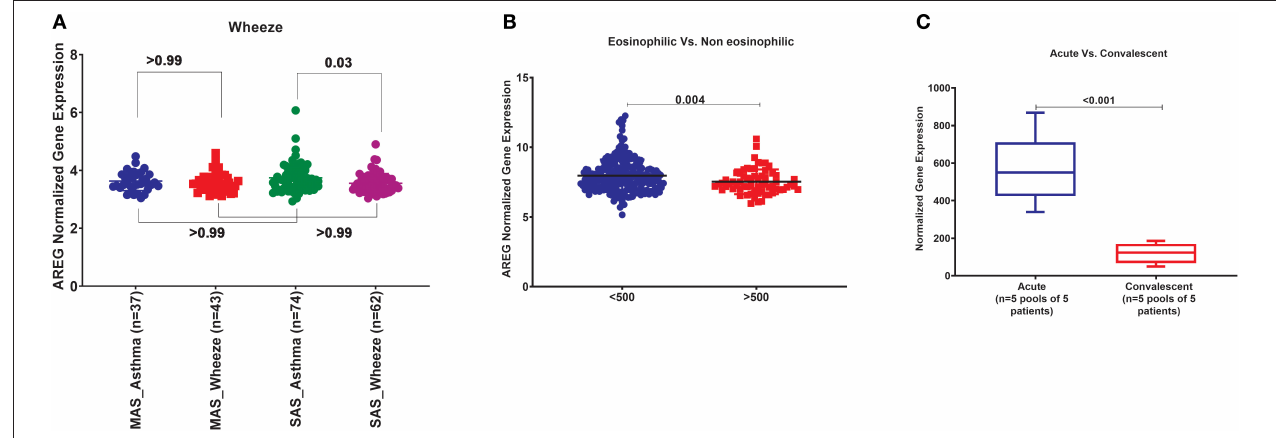
FIGURE 7 | (A) AREG normalized gene expression in whole blood of children with non-severe and severe wheezes were compared to non-severe and severe asthmatics extracted from the expression profile of publically available datasets (GSE123750), where non-severe asthmatic (MAS_Asthma) and severe asthmatic (SAS_Asthma) patients were compared to patients presented with non-severe wheezes (MAS_Wheeze) and severe wheezes (SAS_Wheeze). (B) Normalized gene expression of genes identified in whole blood of eosinophilic asthma ( > 500 cells) compared to non-eosinophilic (eosinophils count less than 500) extracted from the